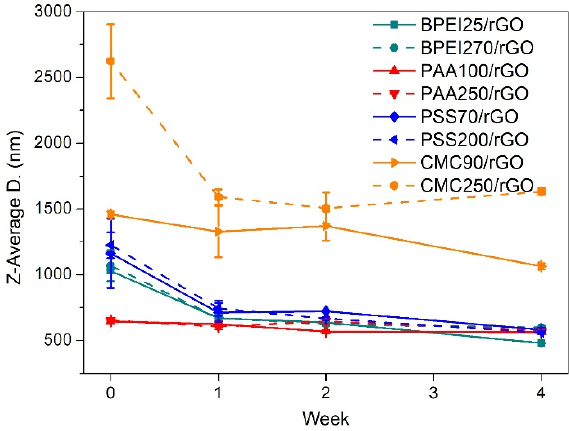
Figure 4. Average size of suspended rGO with different aging times.